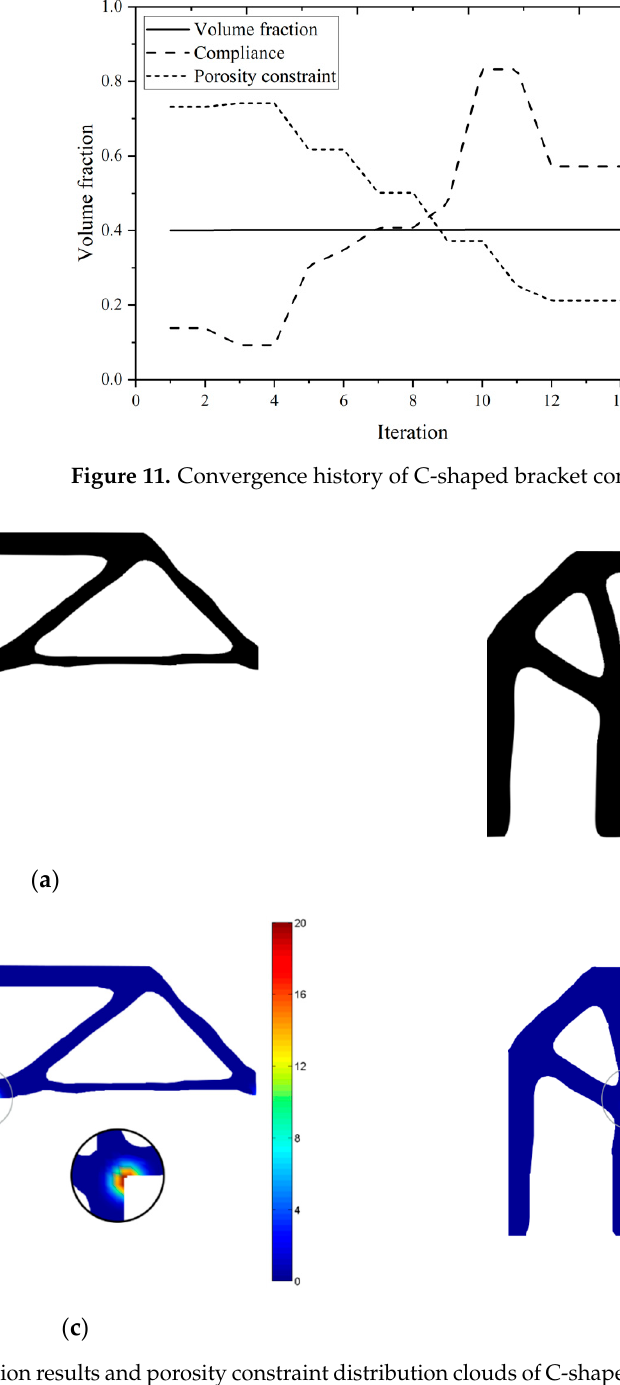
Figure 12. Optimization results and porosity constraint distribution clouds of C-shaped bracket, ( a ) optimized shape without considering porosity constraint; ( b ) optimized shape considering porosity constraint; ( c ) porosity constraint distribution clouds without considering porosity constraint; ( d ) porosity constraint distribution clouds considering porosity constraint.